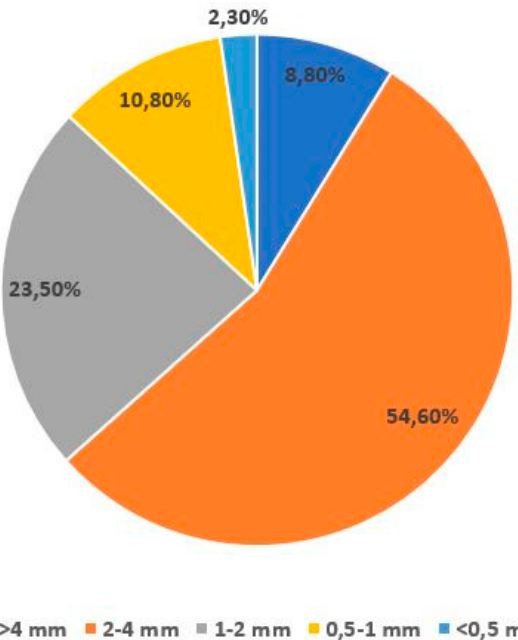
Figure 2. Particle size distribution of dried BSG.